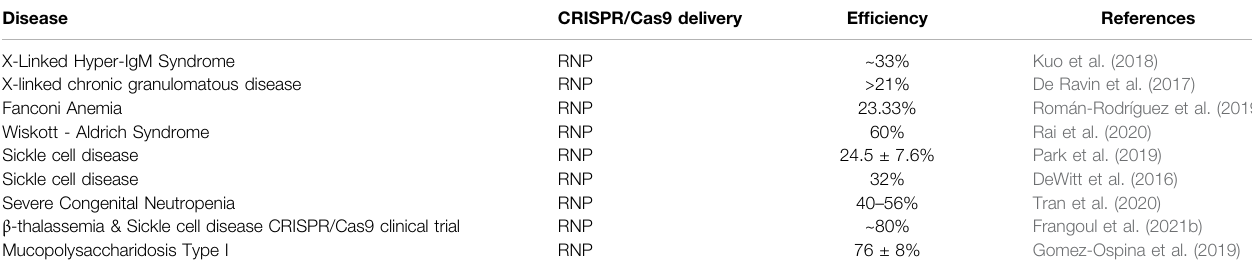
TABLE 2 | Ribonucleoprotein (RNP) mediated delivery of CRISPR/Cas9 in patient derived CD34 + HSPCs.